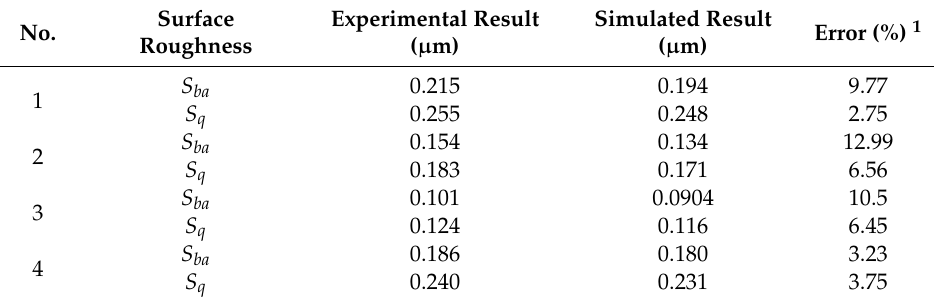
Figure 2. Comparison of surface topography ( v c = 250 m / min, f z = 0.3 mm / z, a e = 1.8 mm, a p = 0.2 mm): ( a ) Experimental result; ( b ) simulated result. Table 2. Results of the validation experiment.